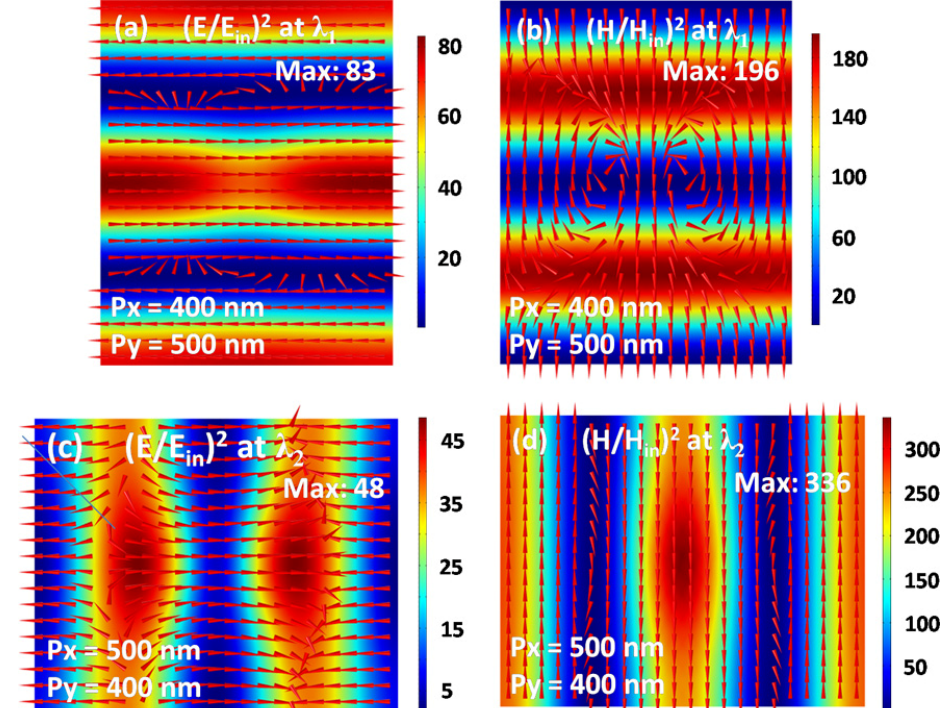
Figure 3. The intensity distributions on the xoy plane of electromagnetic fields in the ITO film for the resonance wavelength λ 1 ( a,b ) and the resonance wavelength λ 2 ( c,d ).